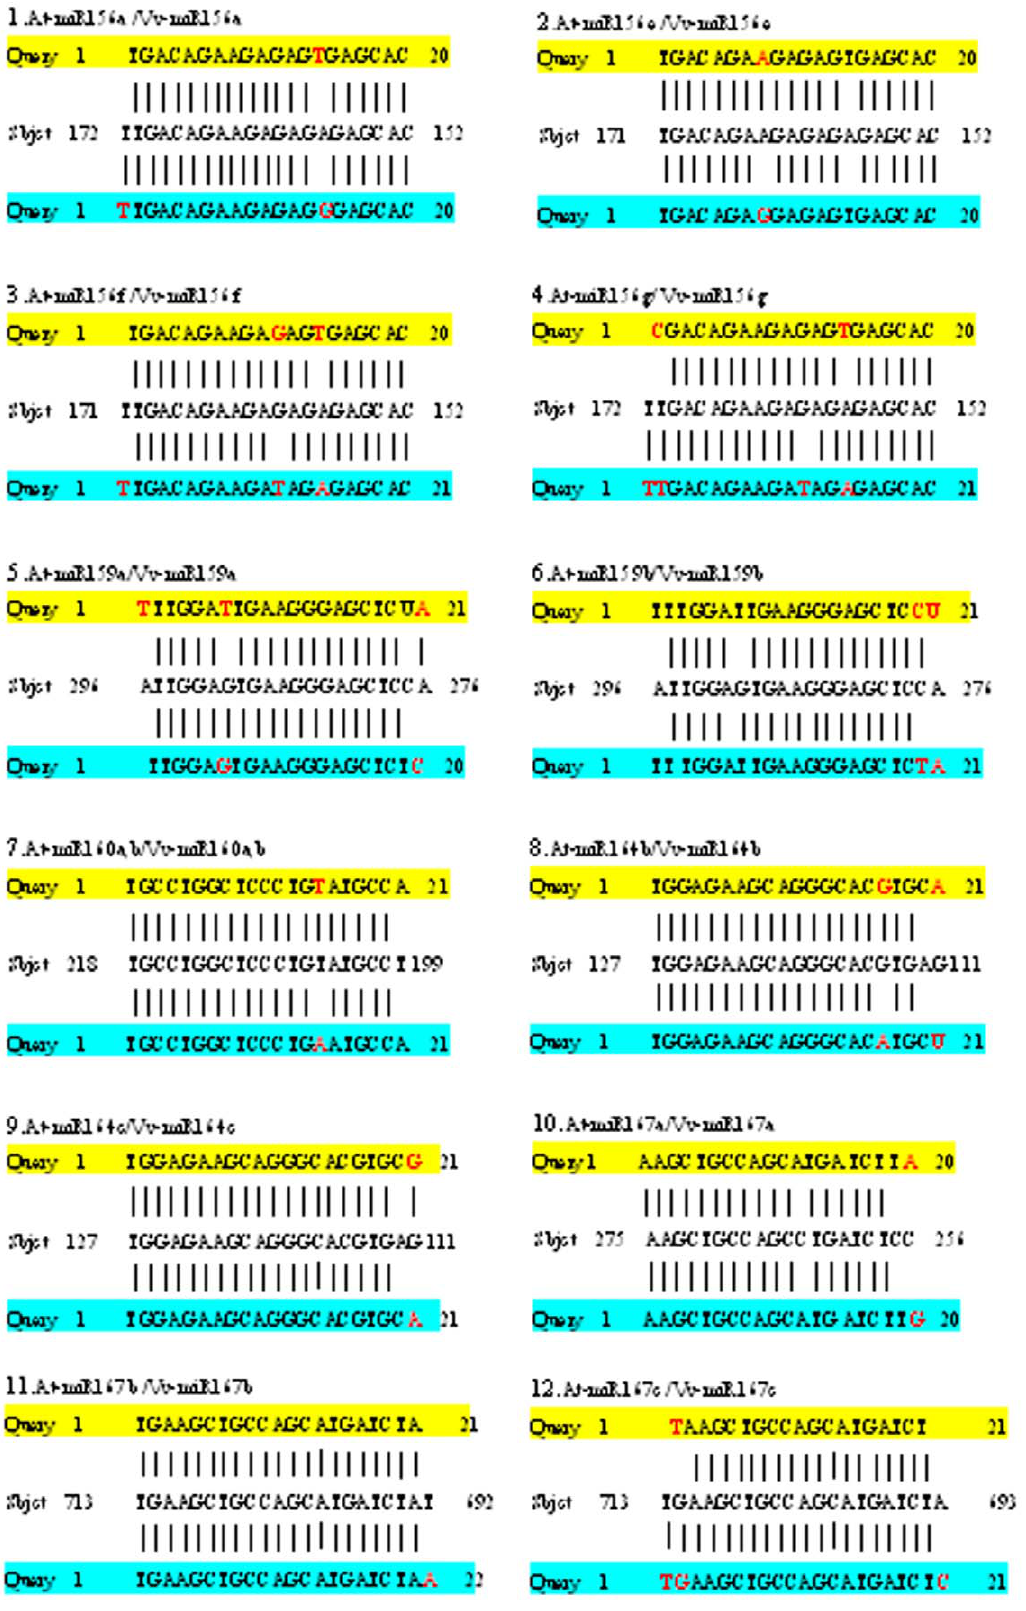
Figure 2. Comparison of the uncomplementary bases of orthologous miRNAs from Arabidopsis and grapevine with the same target sequence. The yellow regions are Arabidopsis miRNAs sequences, the blue regions are grapevine miRNAs, and the middle sequences are the complementary sequences on target genes of grapevine. doi:10.1371/journal.pone.0021259.g002 PLoS ONE |